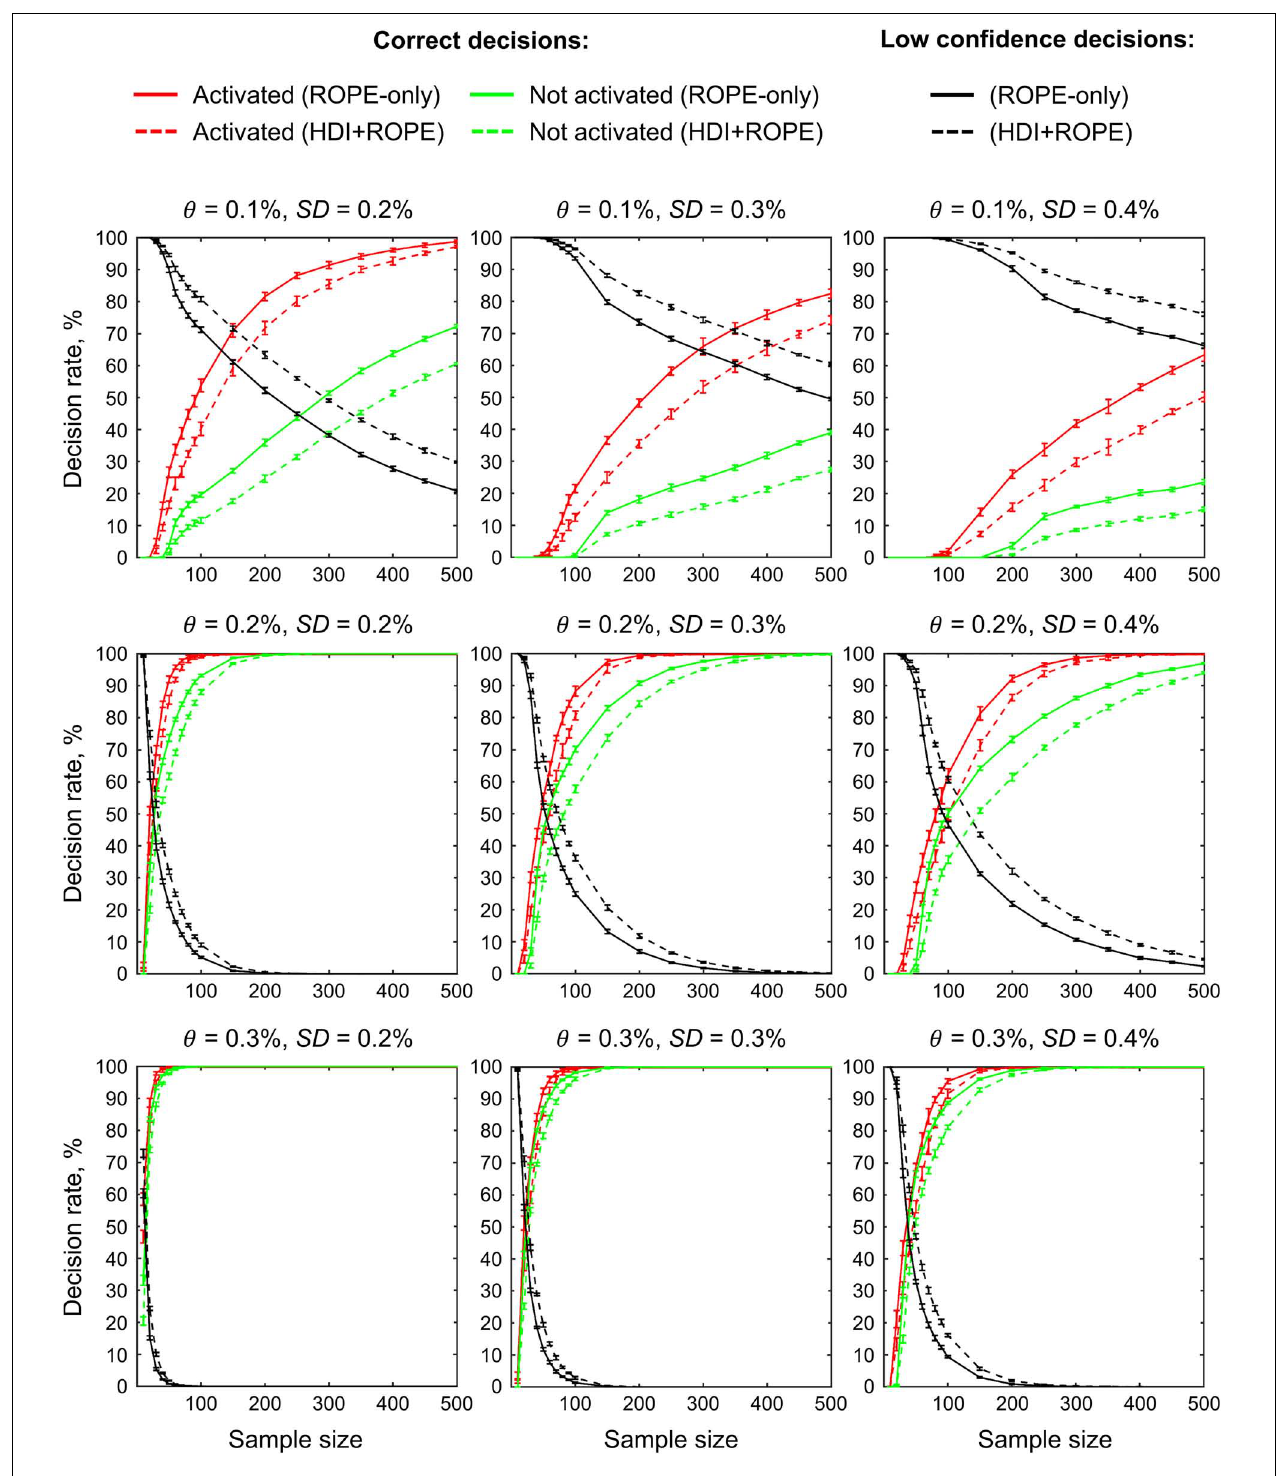
FIGURE 16 | Simulations results for the dependencies of the correct and low confidence decision rates on the sample size. Data were drawn from normal distributions with different mean effect θ and noise SD . BPI was implemented using γ = 1 prior SD θ . The plots for ‘deactivated’ voxels closely follow the plots for ‘activated’ voxels and have therefore been omitted for visualization purposes. The error bars represent the mean and standard deviation across ten random